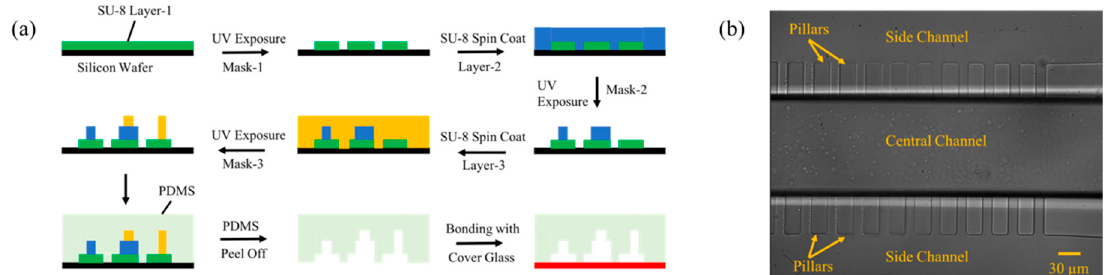
Figure 3. Schematics illustrating the multi-step variable height lithography and a micrograph of the fabricated device. ( a ) Schematic represents the various steps involved in achieving the 3 different heights into the Master mold and then transferring them into the PDMS device in a single shot. ( b ) Micrograph of the PDMS device that was fabricated and shows the image of the device towards the end of Section